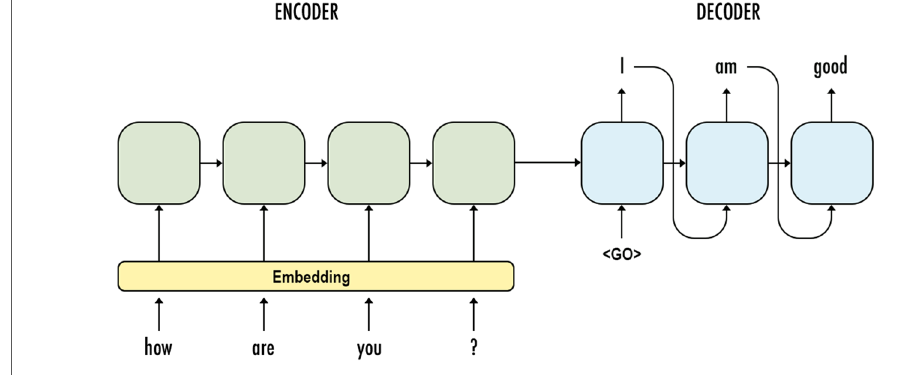
Fig. 2 Sequence‑to‑sequence model